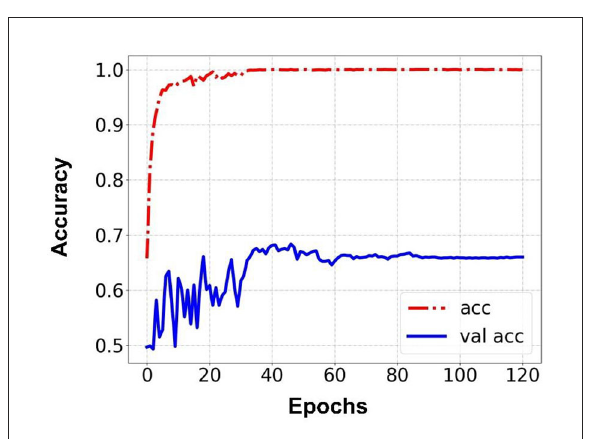
FIGURE3 Accuracy for Task 2 in an